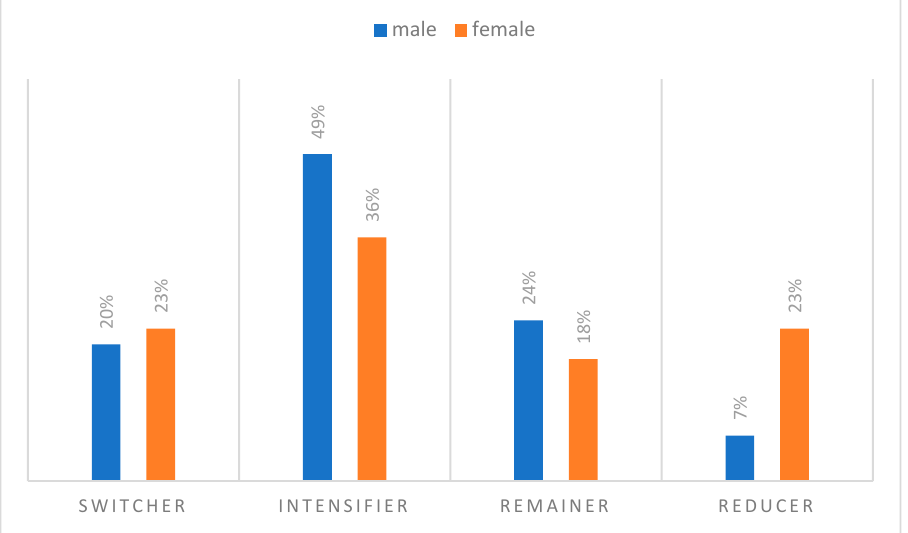
Figure 2. Types of religious changes in prison by gender.